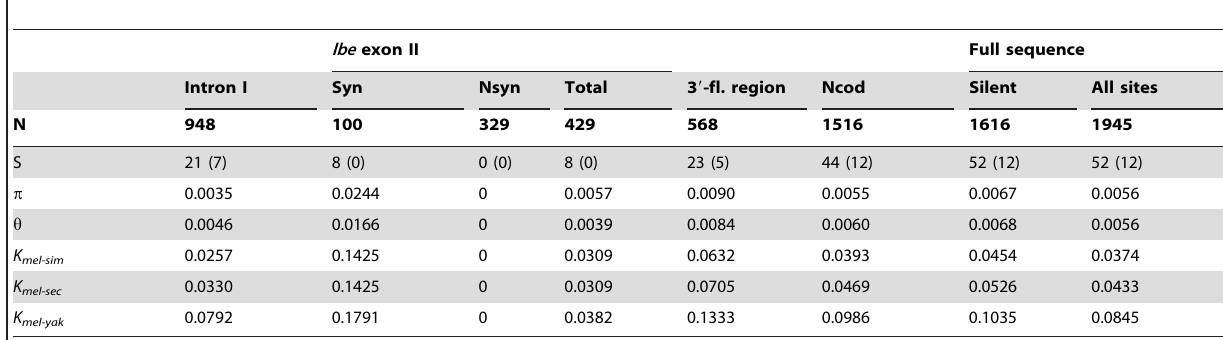
Table 1. Nucleotide diversity and divergence in the lbe gene region of D. melanogaster .